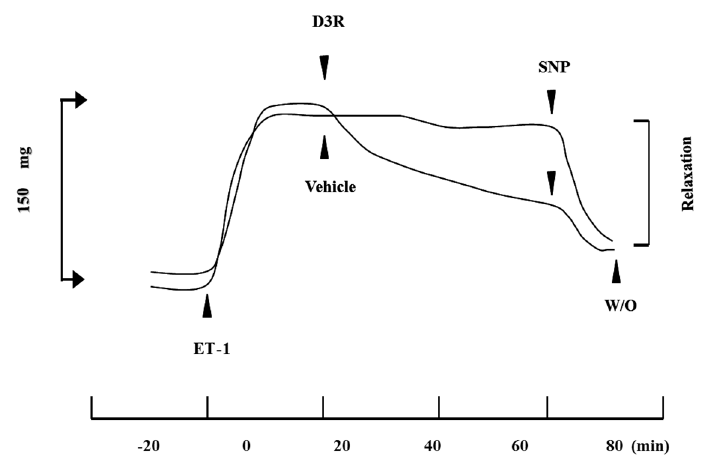
Figure 5. Ciliary muscle relaxation by D3R against ET-1induced contraction. 10 nM ET-1 produced a phasic contraction, followed by a tonic contraction. When the tonic contraction reached a steady